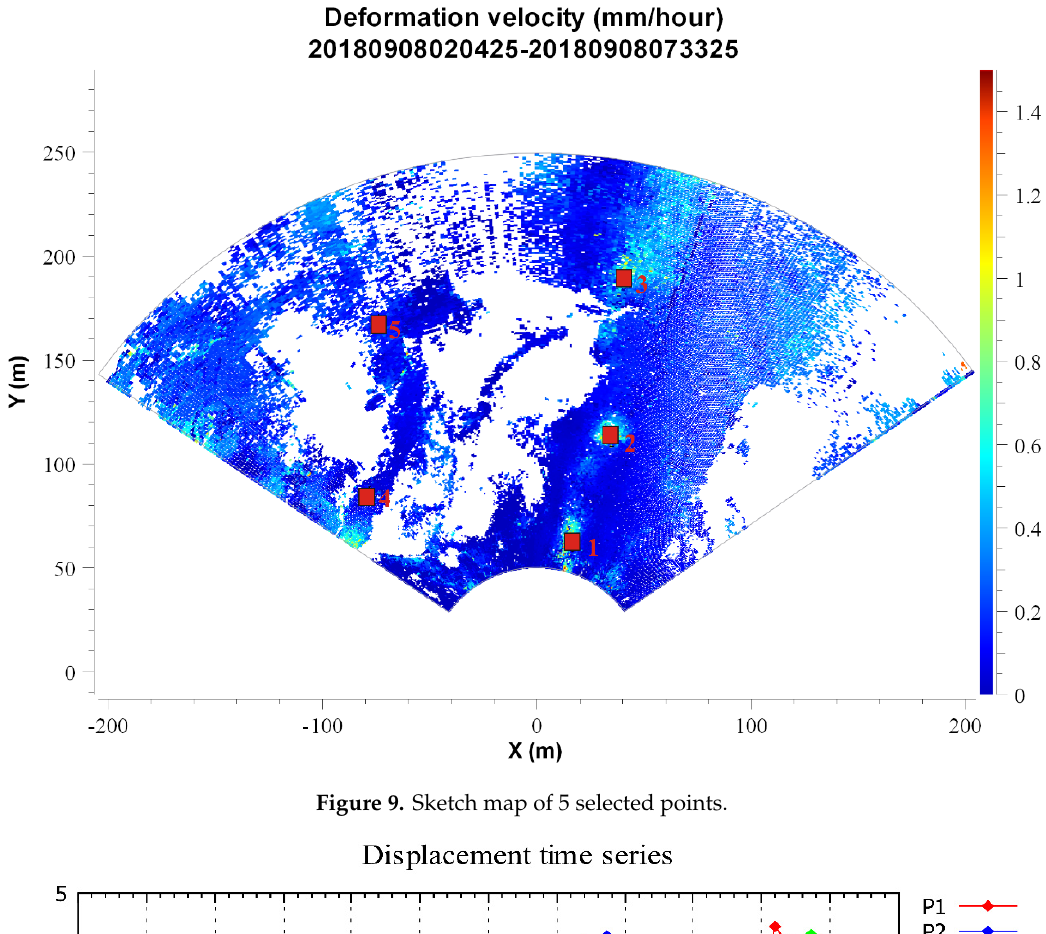
Figure 9. Sketch map of 5 selected points.